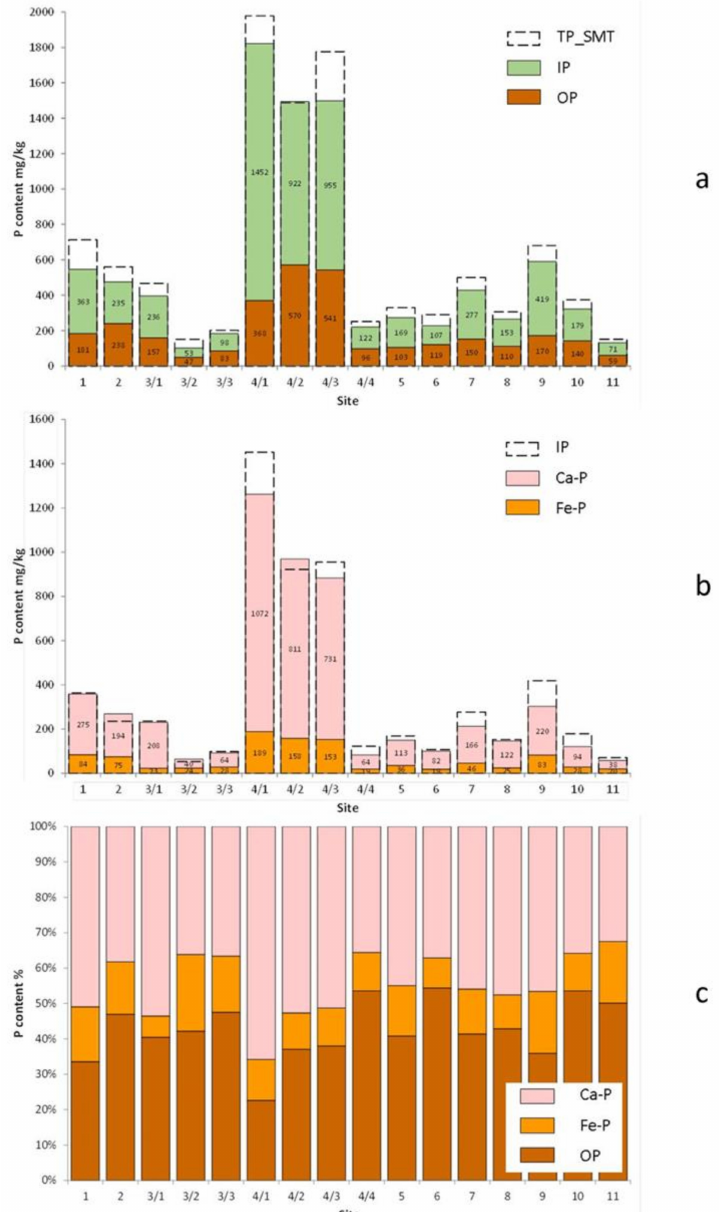
Figure 2. Total phosphorus (TP SMT ) and P forms determined from grab samples: ( a ) Inorganic-P (IP) and organic-P (OP), compared to TP SMT; ( b ) calcium-bound P (Ca-P) and P bound to Al, Fe and Mn oxy-hydroxides (Fe-P) compared to IP; ( c ) percent contribution of OP, Fe-P and